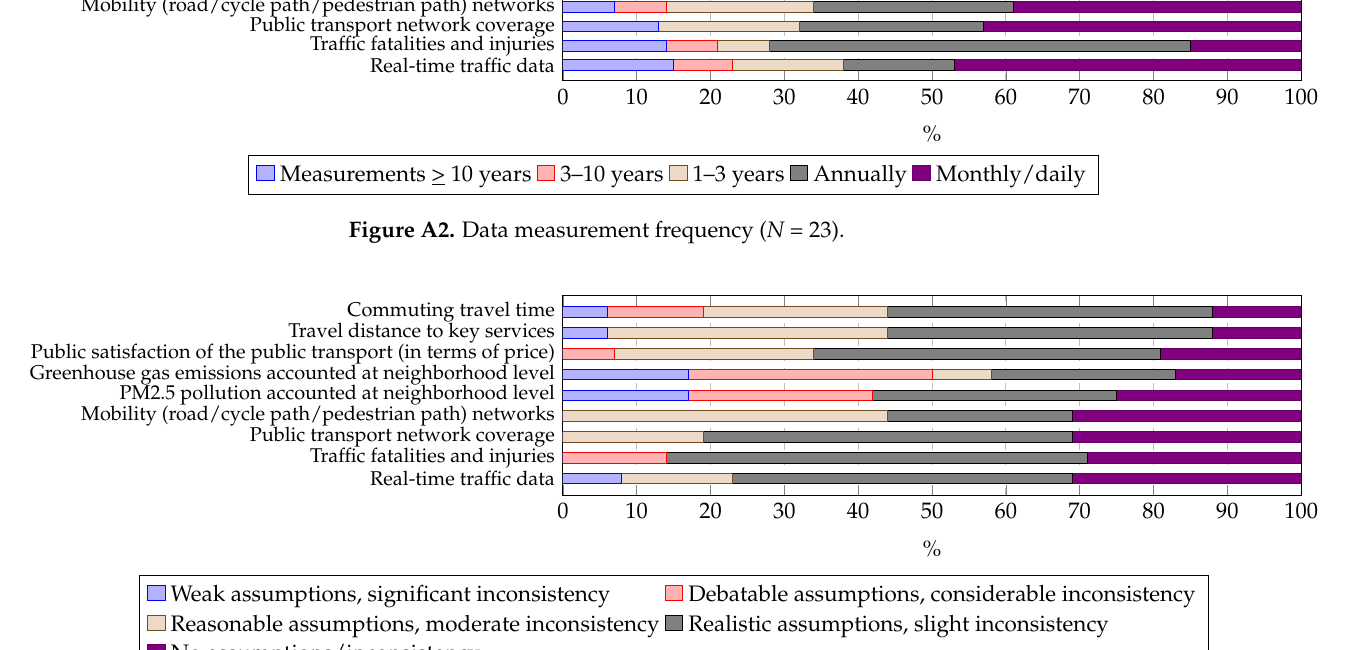
Figure A3. Data reliability ( N =